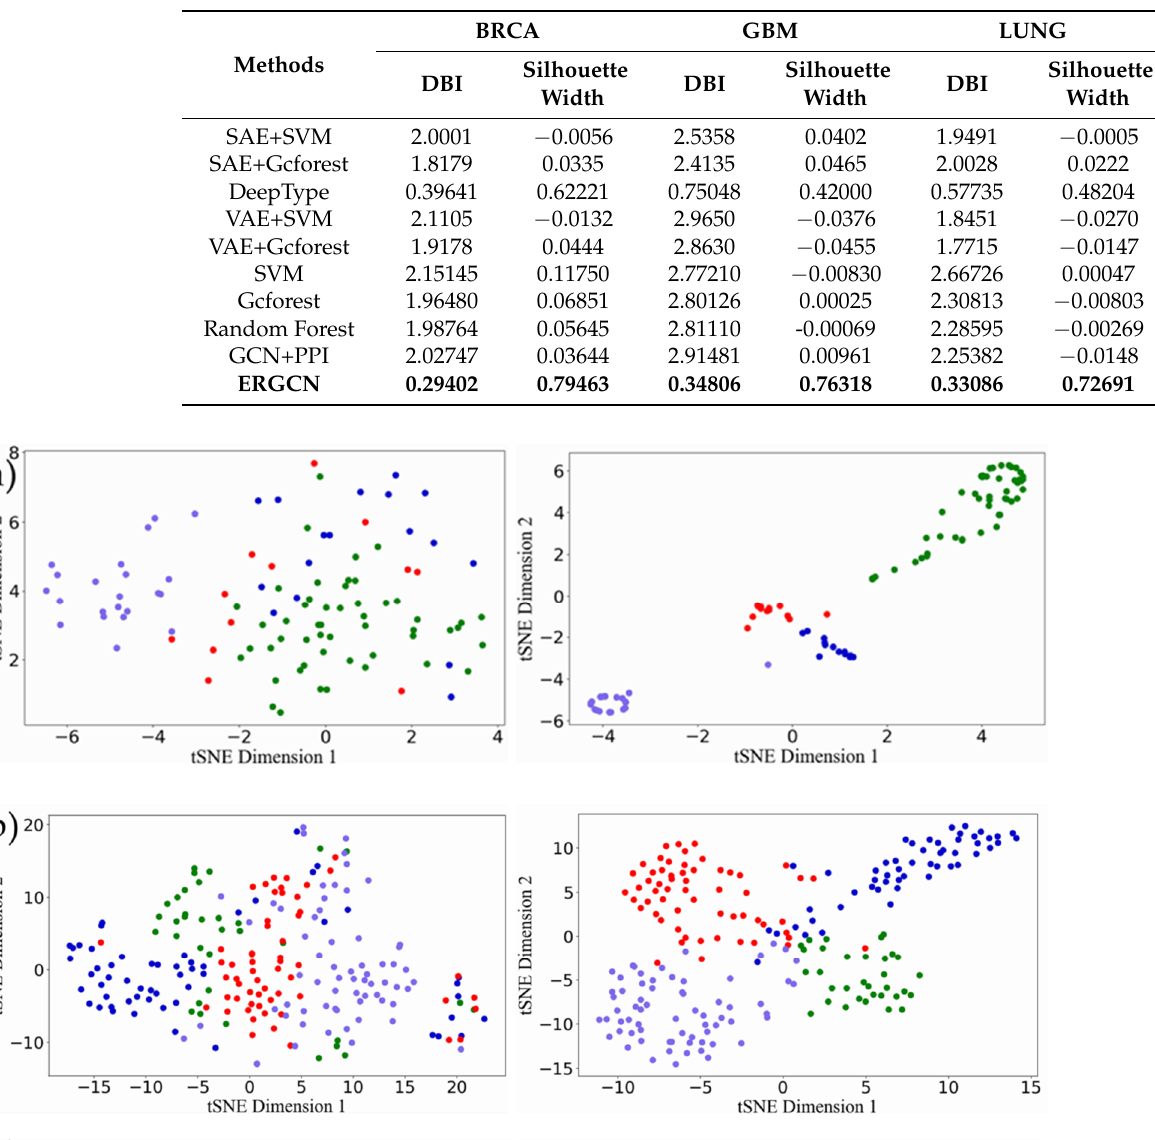
Table 4. The internal evaluation metrics of every model.